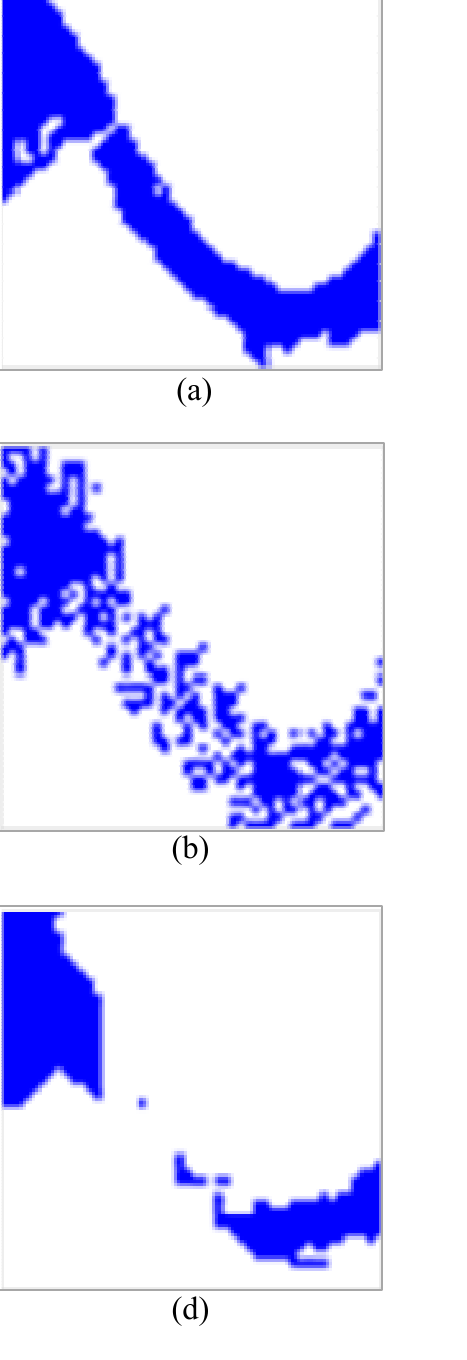
Figure 6. Zoom for small part 1 of inundation reference image and different SUIM results for Wuhan. ( a ) Inundation reference image; ( b ) BPNN ‐ SUIM; ( c ) SVM ‐ SUIM; ( d ) SAM ‐ SUIM; ( e ) SAMENN ‐ SUIM.